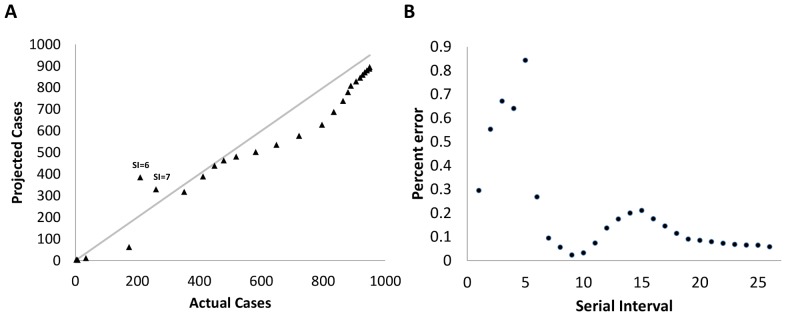
Utility of the IDEA model in evaluating the impact of public health and social or environmental factors on outbreak behaviour.(a) The utility of the IDEA model in evaluating the level of control over the outbreak. Each projection is based on the outbreak up to i intervals, projected to the i+1th interval. With the exception of serial intervals 6 and 7 illustrated in the figure, the projected case counts were less than the actual case counts implying that at each serial interval the outbreak grew more than would be expected by its previous course. During this outbreak, the model underestimated the actual number of cases except during two serial intervals. (b) Percent error between the projection for the next generation and actual case counts according to generation.